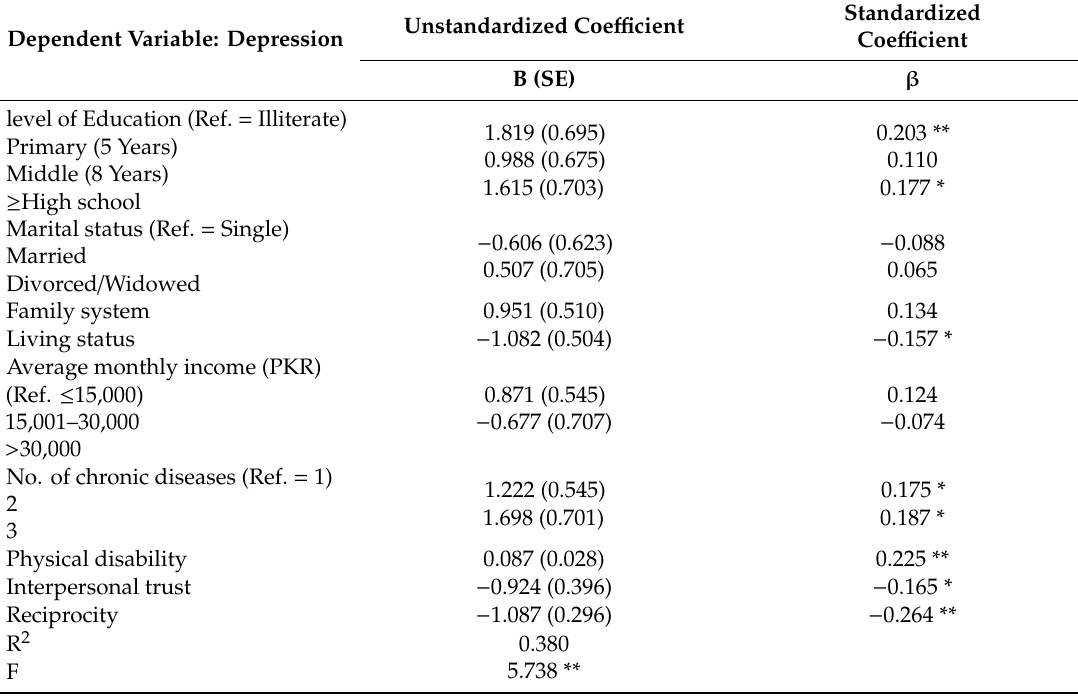
Table 3. Multiple linear regressions on depressive